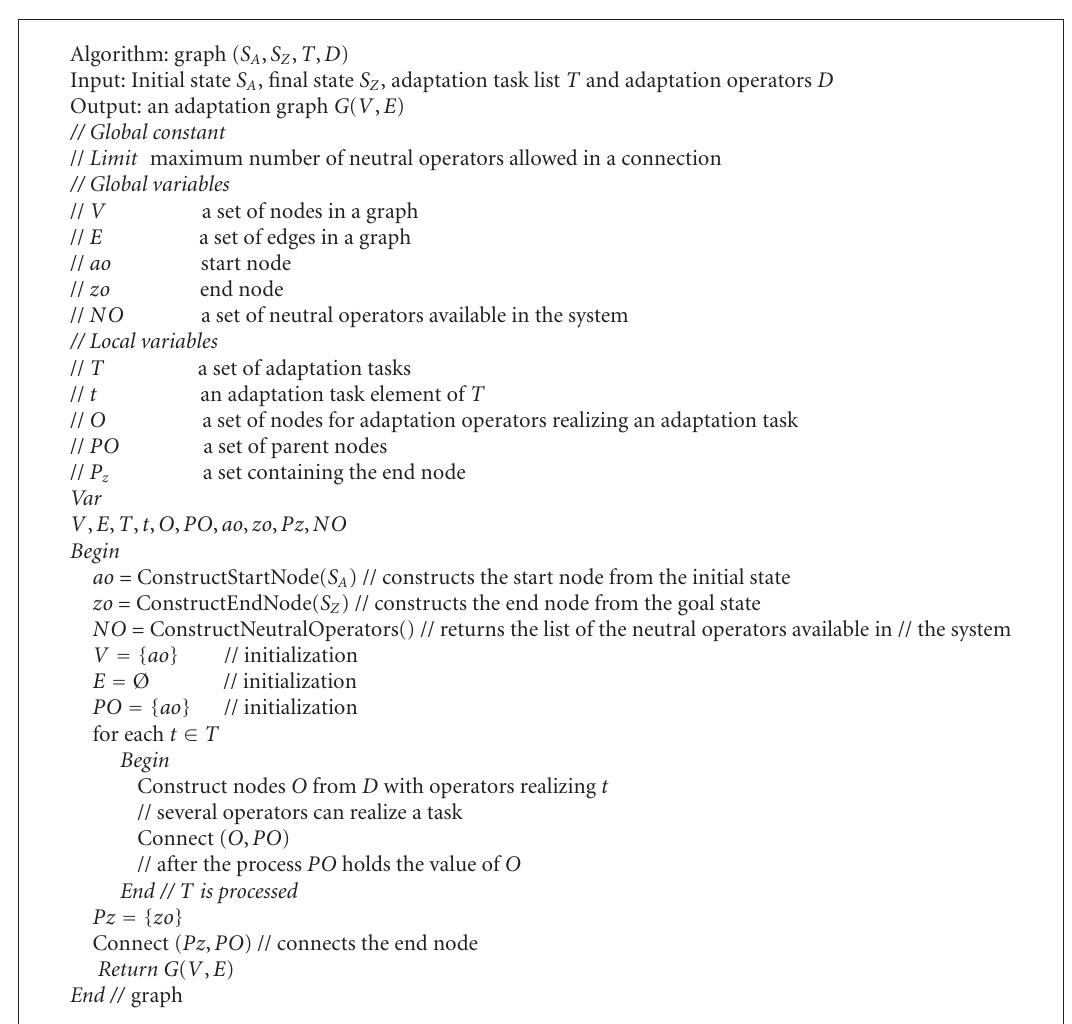
Algorithm 1: The MAGG algorithm